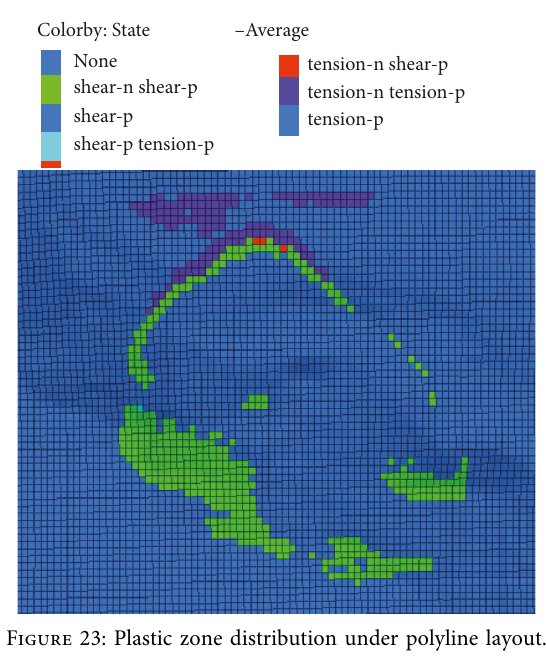
Figure 23: Plastic zone distribution under polyline layout.